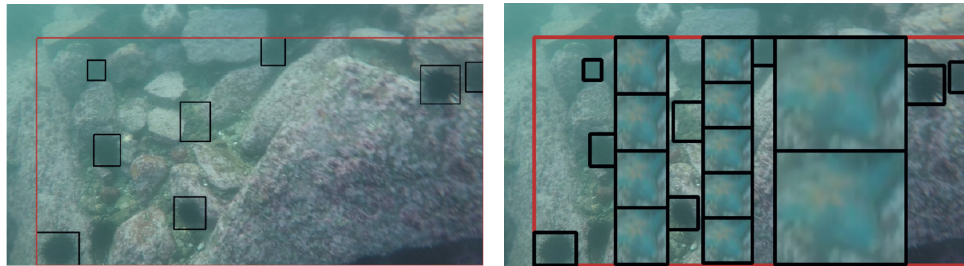
Figure 7. An example of the non-overlapping filling in the vertical direction. The red box represents the minimum closure of all black boxes. The black boxes show the position of the targets.